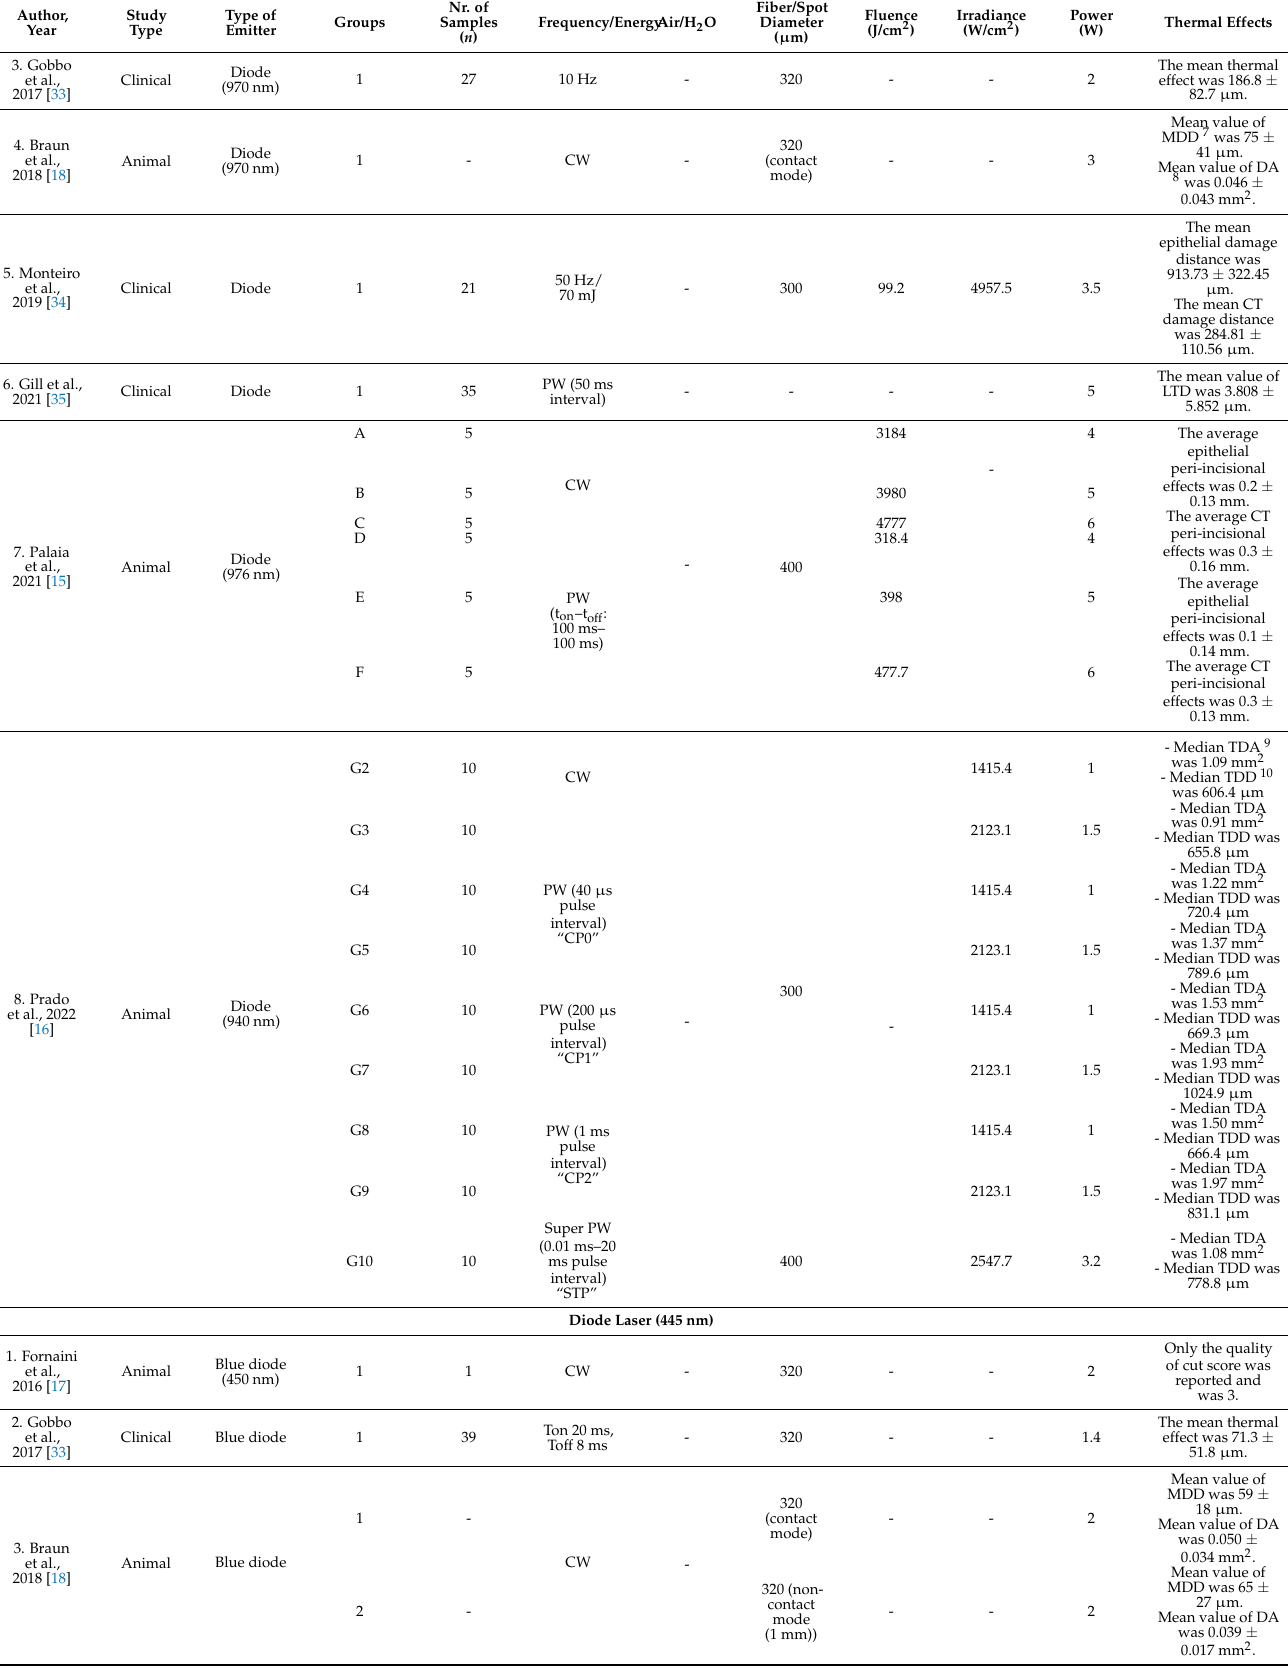
320(non- contact mode (1mm))